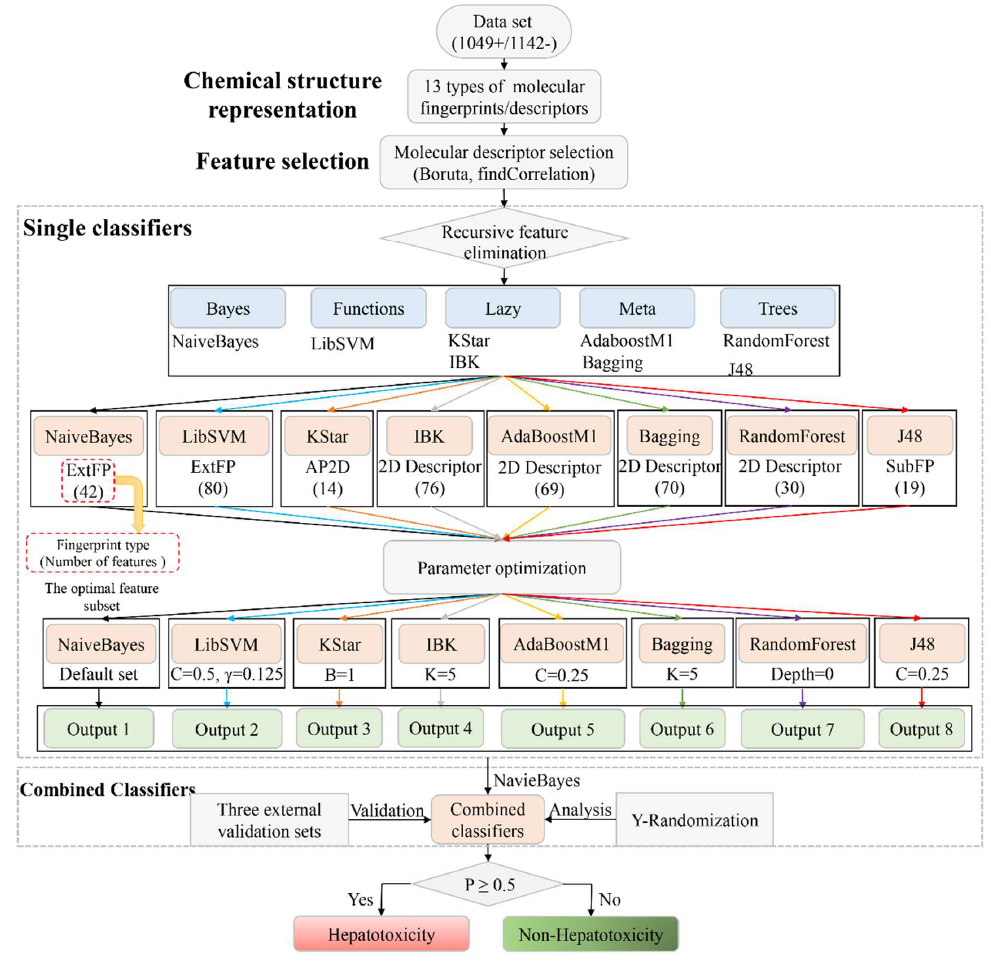
Figure 1. Workflow illustrating the combined classifier framework for predicting drug induced liver injury.